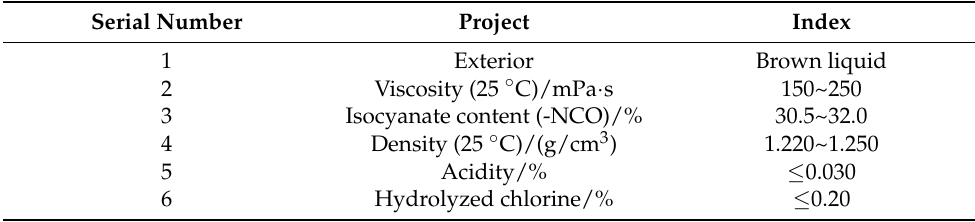
Table 2. Physical and chemical properties of WANNATE ®® PM-200.